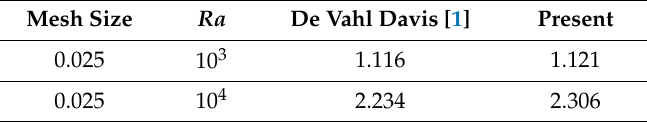
Table 3. Variations of Nu for Ra = 10 3 and 10 4 compared with the data of De Vahl Davis [1]. Mesh